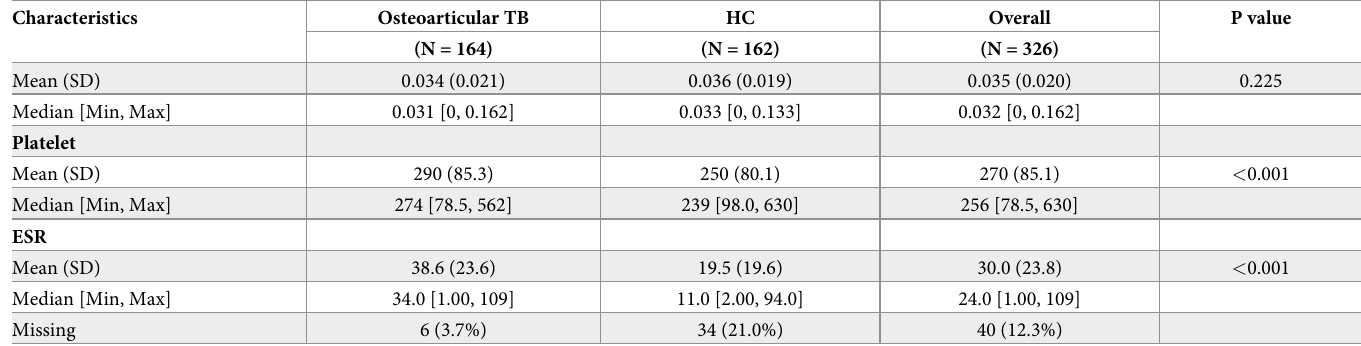
The xCell score of 64 subtypes for each sample was calculated based on the expression file (S1 File). The xCell score of lymphocytes was sum of all xCell score of lymphoid cells (B cells, T cells and NK cell) in the dataset GSE83456 (S1 Fig). Compared with the HC group in the data- and platelets, but lower xCell score of lymphocytes (Fig 1A). The cell counts of monocytes and platelets were much higher while that of lymphocytes were lower in the osteoarticular TB ferent between the osteoarticular TB and non-TB